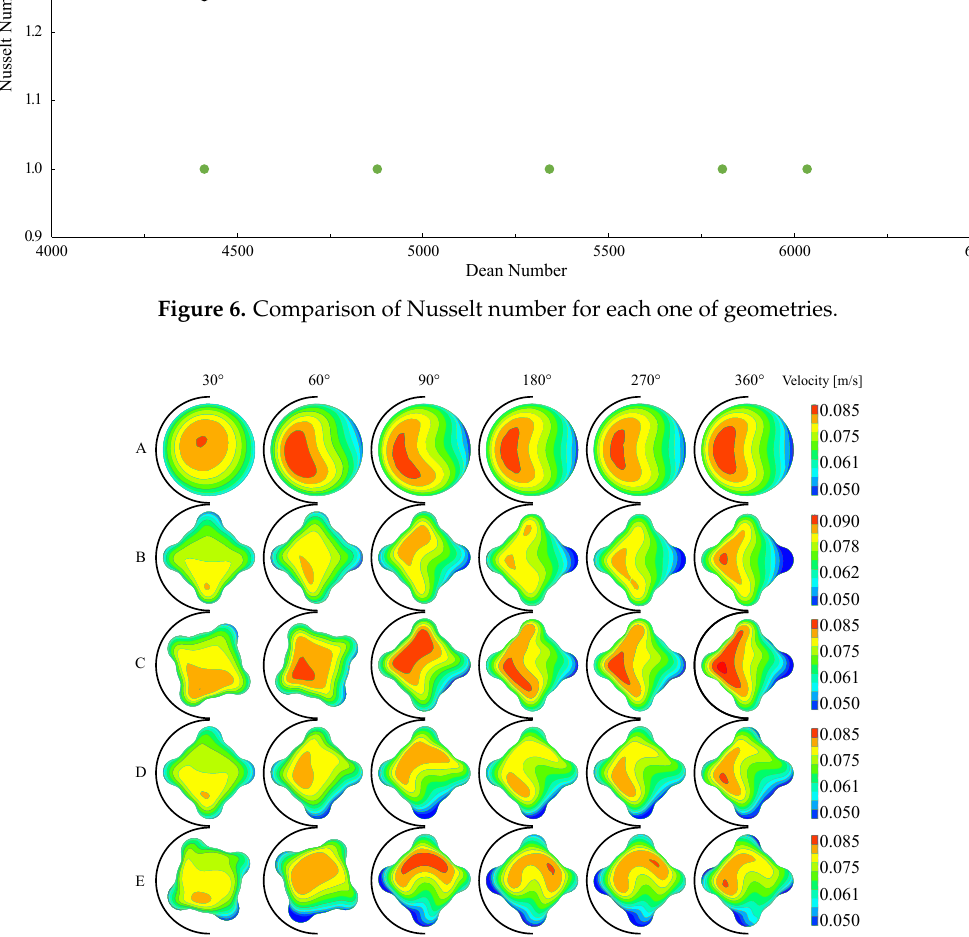
Figure 7. Velocity contours for the inner tube of five heat exchangers with Dean number 1000 for the inner tube and with Dean number 4411 for the outer tube. A: tube-in-tube. B: four ridges without twist. C: four ridges with 1 twist. D: four ridges with 3 twist. E: four ridges with 5